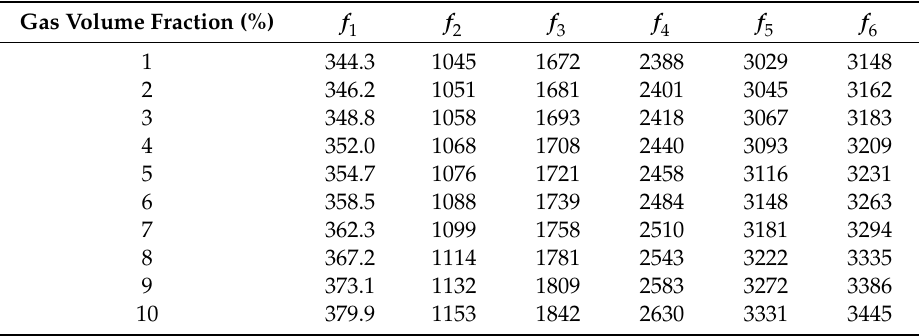
Table 3. The simulation results of gas-phase content relative to the first six order mode vibration frequencies of the measuring